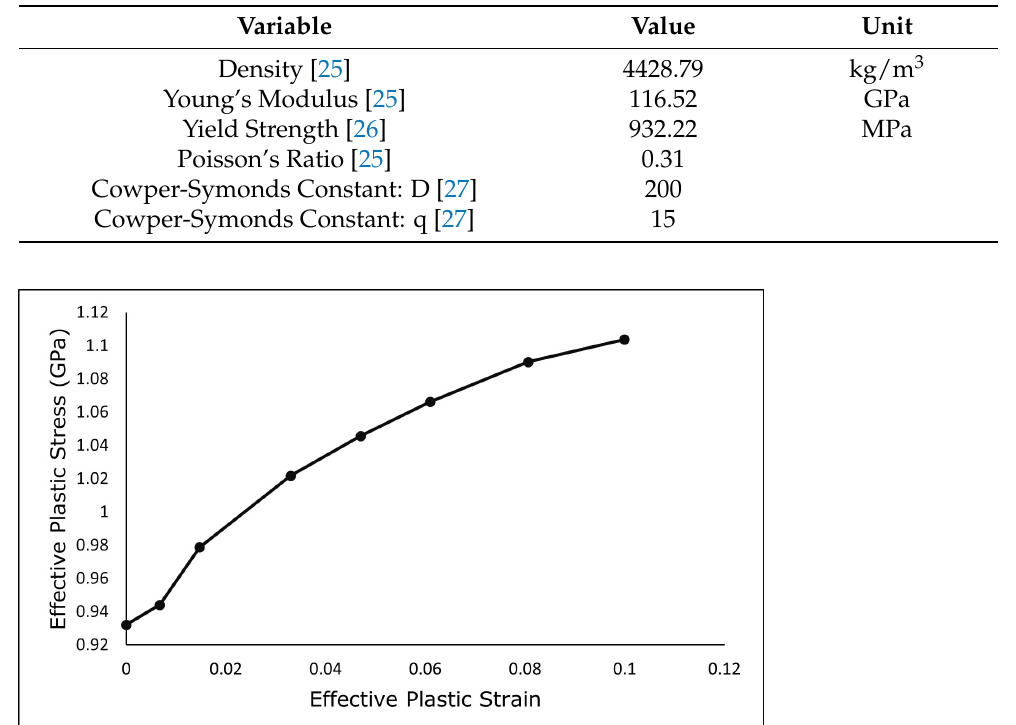
Figure 5. Impactor’s Velocity Curve. Table 4. Ti-6Al-4V Material Properties.